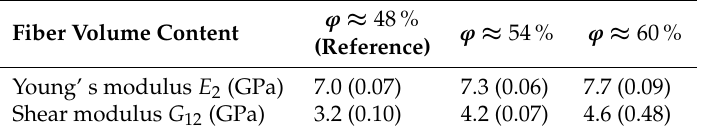
Table 12. Fiber shearing—material properties at different fiber volume contents (median values and IQR in